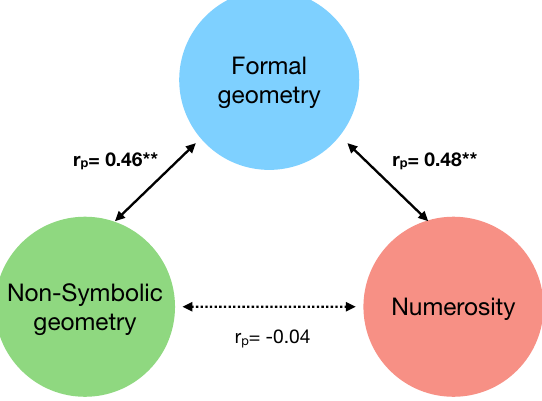
Figure 5. Diagrams of correlations between symbolic and non-symbolic abilities. Values reports partial correlations between the two variables connected by arrows after controlling for age and the third variable. The results refer to the second (most informative) run of the non-symbolic geometry test. **p <= 0.01 p